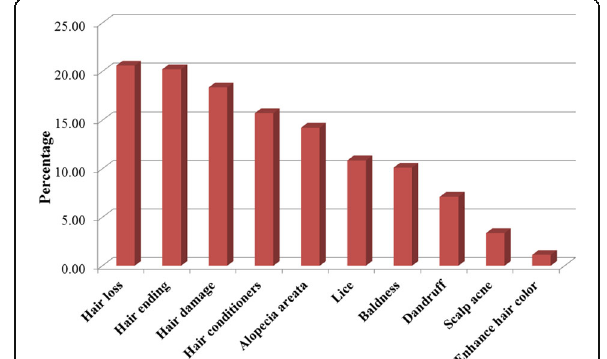
Fig. 4 Hair and scalp disorders treated by herbals